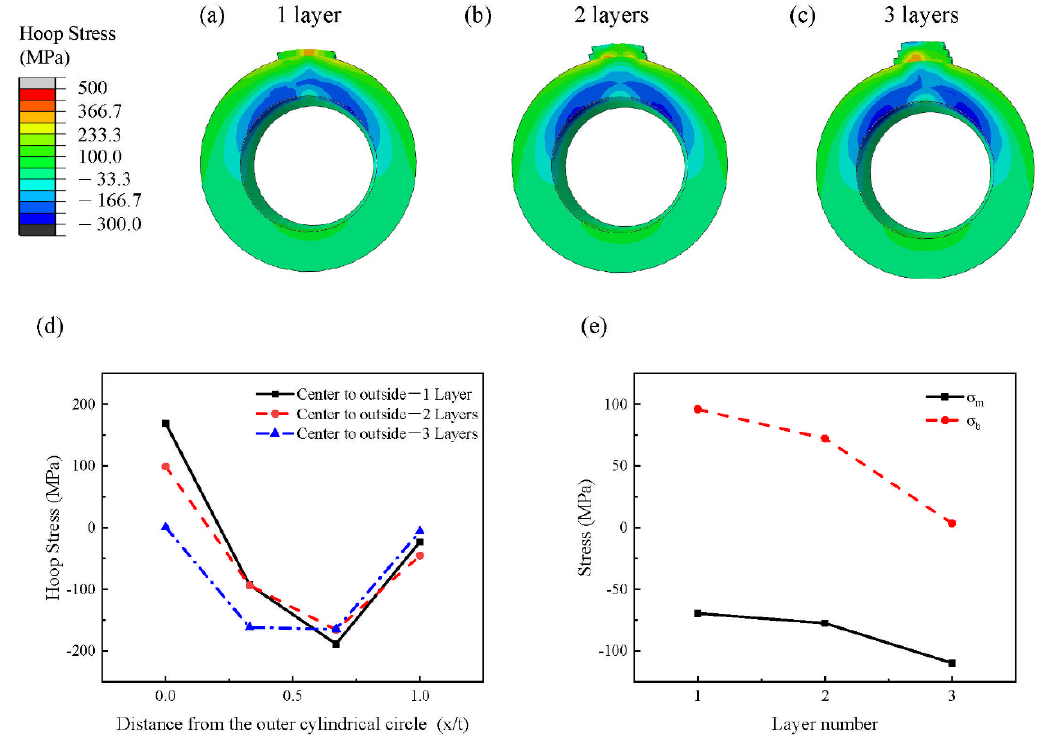
Figure 11. Hoop residual stress distribution at mid-length of the weld overlay joint with center-to-outside welding sequence for ( a ) 1 layer, ( b ) 2 layers, and ( c ) 3 layers, respectively, ( d ) distribution of hoop residual stress in the through-thickness direction, and ( e ) evolution of the decomposed components of hoop residual stress distribution.